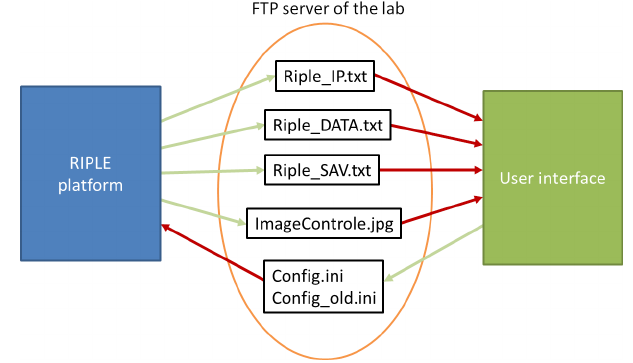
Figure 6. Diagram describing the links between the RIPLE plat- form, the remote server and the user interface. The “Riple_IP.txt” file contains the current IP address (Internet Protocol, public and dynamic) of the RIPLE platform. The “Riple_DATA.txt” file con- tains the data from each instrument of the RIPLE platform. The “Riple_SAV.txt” file contains the data that enable users to remotely control the proper functioning of the RIPLE platform. “Config.ini” is the configuration file of the platform, which is generated when the user wants to change the configuration of the platform from a remote location using the RIPLE interface (Sect. 5). A backup of the old configuration is made in the “Config_old.ini” file. “image- Controle_Date.jpg” is the image file that the data logger puts on the FTP server. A copy of the image is saved locally on the cam- era in order to make a reliable archiving of the images (in case of malfunction of the remote transmission for